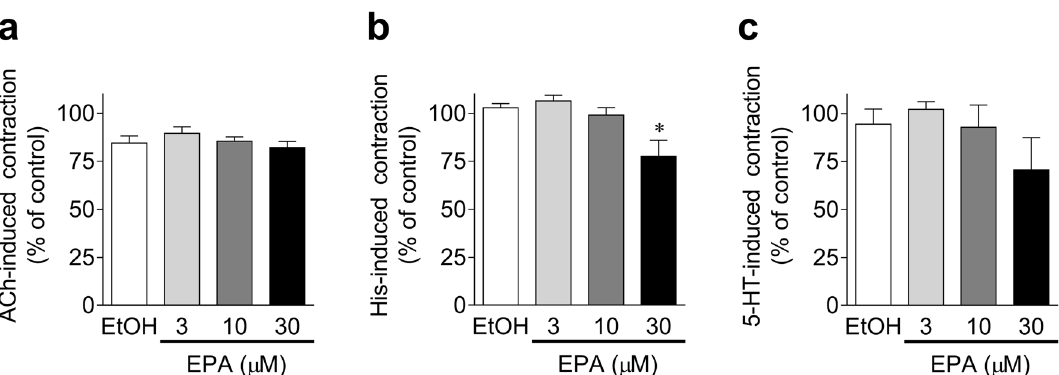
Figure 3. Quantified data of effects of 3–30 μM eicosapentaenoic acid (EPA) and 0.1% ethanol (EtOH) on porcine coronary artery phasic contractions induced by 3 μM acetylcholine (ACh, a ), 10 μM histamine (His, b ), and 30 μM serotonin (5-HT, c ). Data are presented as mean ± SEM [n = 6 ( a ) and n = 5 ( b , c )]. *P < 0.05 versus EtOH (Dunnett’s test after one-way